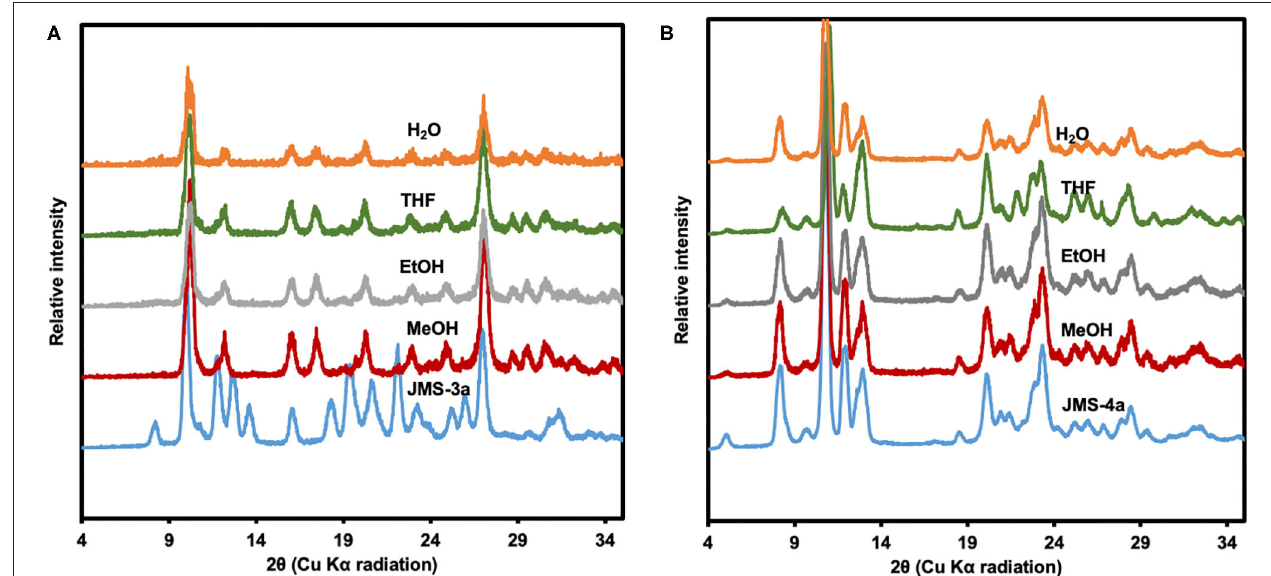
FIGURE 9 | (A) PXRD patterns of JMS-3a (B) JMS-4 soaked in several solvents for 36h.